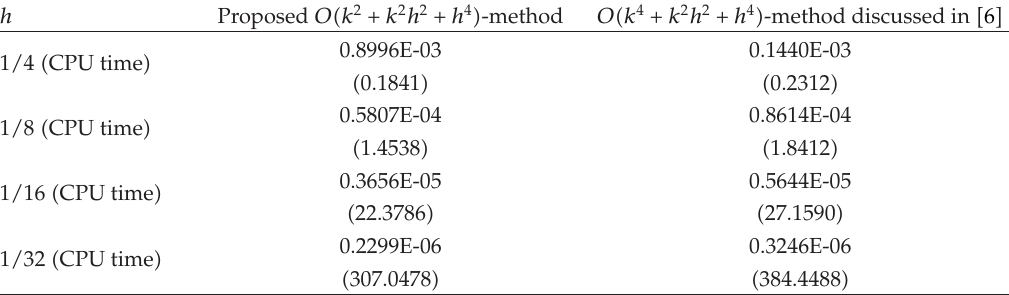
Table 4: Example 6.4: the maximum absolute errors (cid:4) with CPU time (cid:5) .